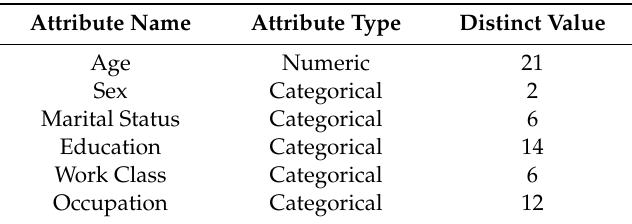
Table 14. Description of retrieved Adult datasets.